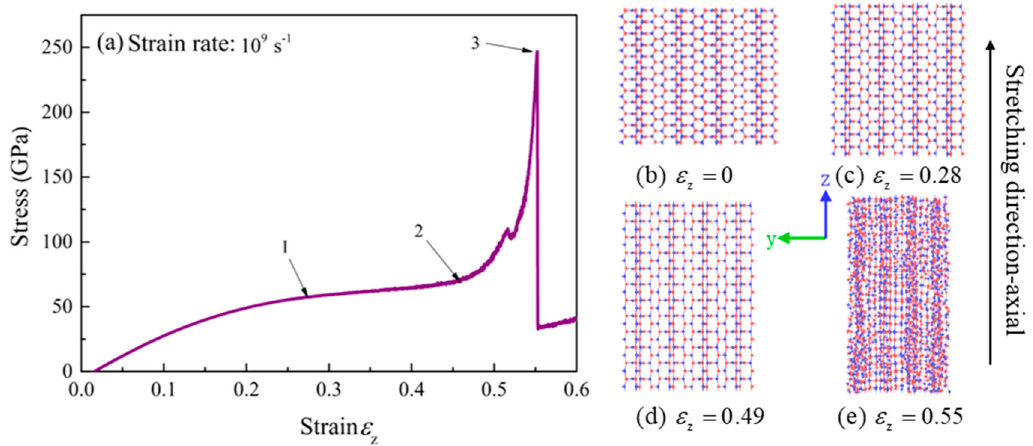
Figure 5. ( a ) The stress-strain curve of BNHCs under tensile loading along the axial direction; ( b – e ) Deformation of BNHCs under different tensile strains along the axial direction.